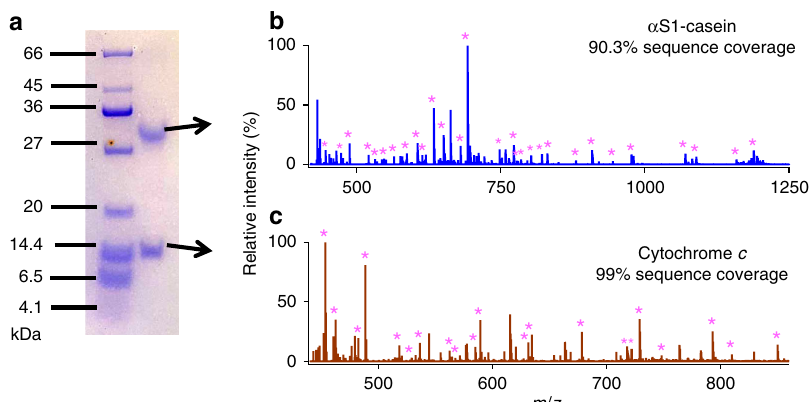
Fig. 5 Trypsin microdroplet digestion of proteins with ESSI-MS ( + 3 kV) after PAGE gel separation. a PAGE gel showing the protein ladder and two protein bands stained with Coomassie blue. Mass spectra showing the microdroplet digestion of b α -casein and c cytochrome c. Magenta asterisks denote the peptide fragments.